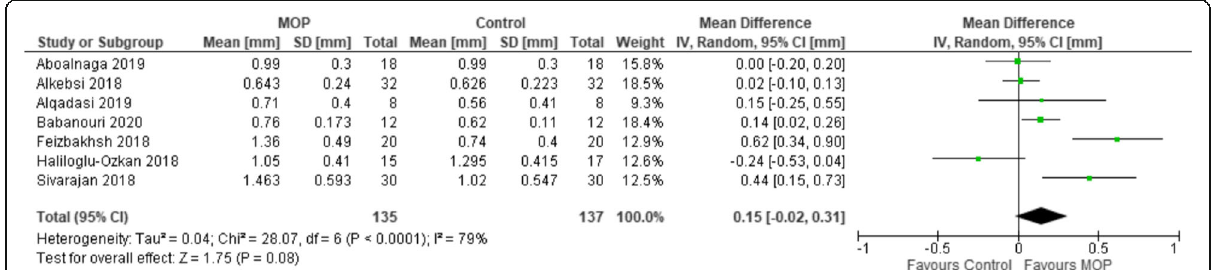
Fig. 4 Forest plot for the mean difference of the monthly rate of tooth movement comparing studies that used conventional